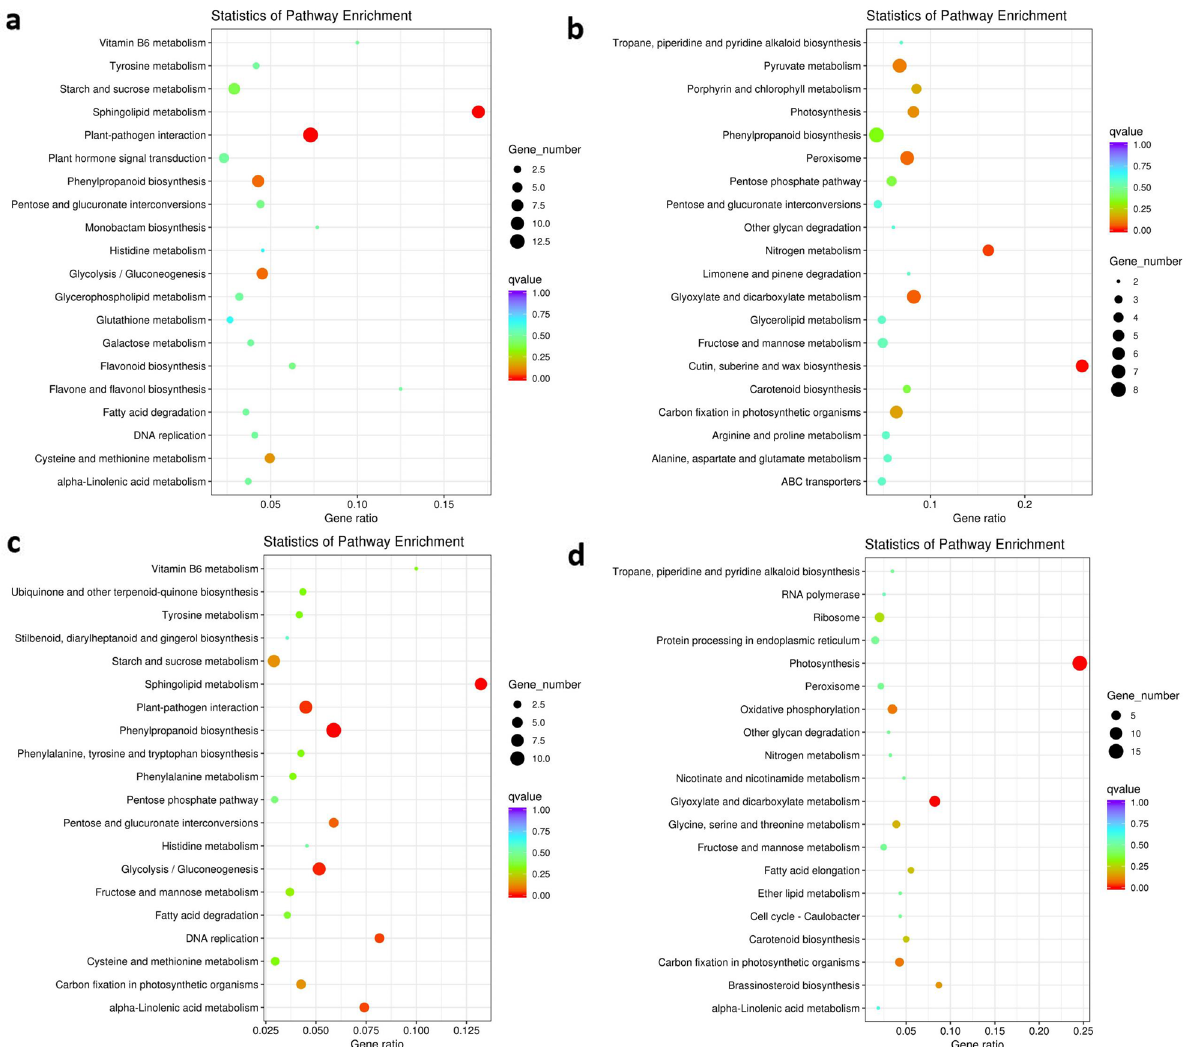
Figure 7. KEGG enrichment analysis of the DEGs in CK versus G5 and CK versus G10. ( a ) Down-regulated unigenes in control and 5% 1-G4 treated BS. ( b ) Up-regulated unigenes in control and 5% 1-G4 treated BS. ( c ) Down-regulated unigenes in control and 10% 1-G4 treated BS. ( d ) Up-regulated unigenes in control and 10% 1-G4 treated BS. X-axis represents the gene ratio; Y-axis represents the KEGG pathway, the size of spots represents the number of gene, and the color of spots represents the q-value of